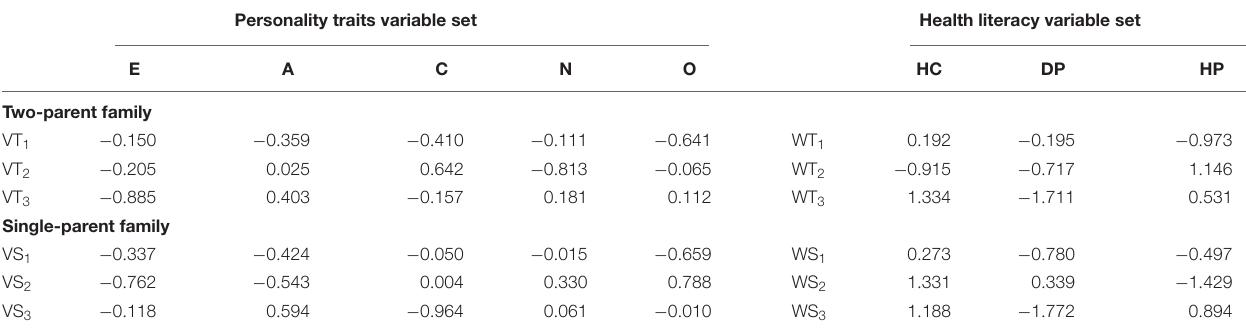
TABLE 6 | Standardized canonical coefficients for personality traits and health literacy in two types of family